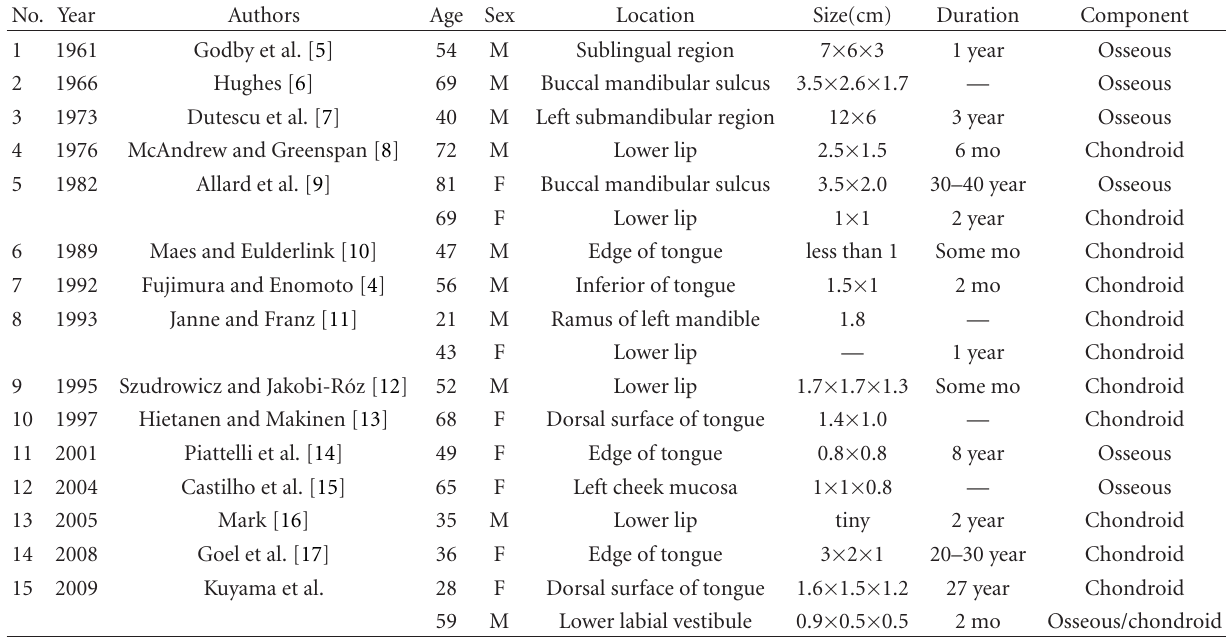
Table 2: Features of the 18 cases of oral lipoma with osseous/chondroid di ff erentiation described in English literature from 1960 to 2009. No.